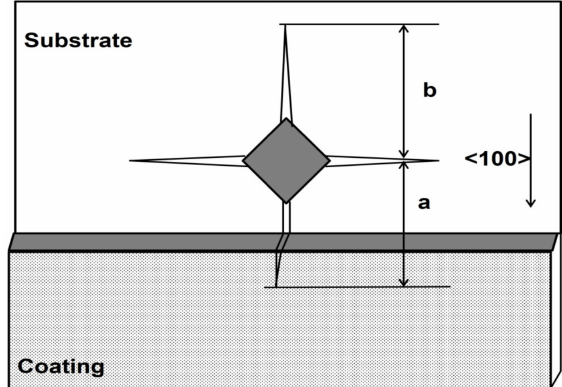
Figure 1. Schematic of the indentation geometry